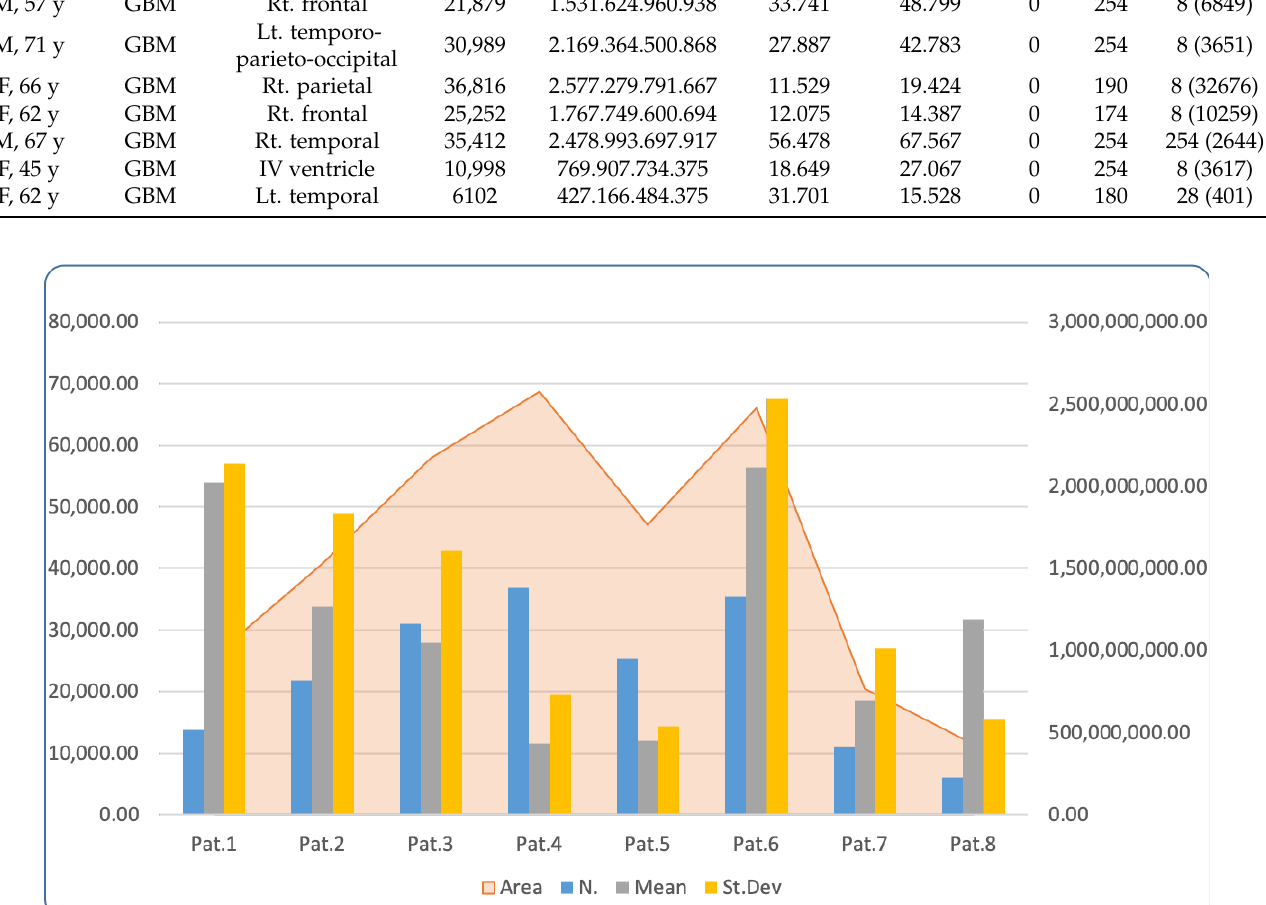
Figure 3. Graphic data from first-order radiomic analysis performed with ImageJ on the first eight GBM patients as specified in Table 2. Area in expressed in px 2 on secondary Y-axis.